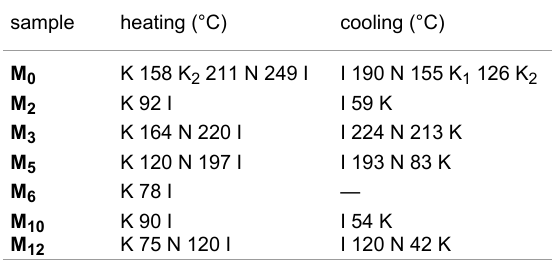
Table 1: Phase transition temperatures of the